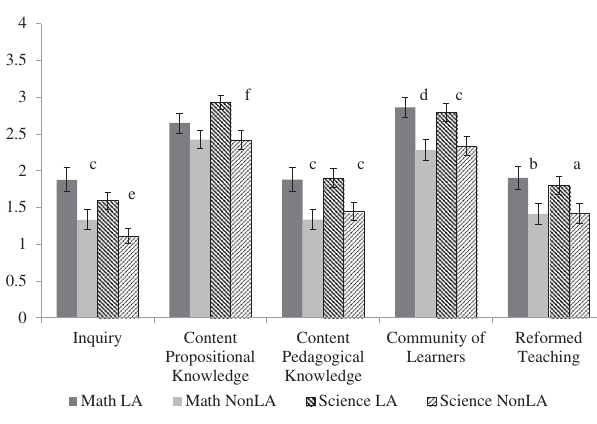
FIG. 3. Average statement response for the five factors of the RTOP. Error bars represent plus and minus 1 standard error on the mean. (a) p ¼ 0 . 03 , (b) p ¼ 0 . 02 , (c) p ¼ 0 . 01 , (d) p ¼ 0 . 003 , (e) p ¼ 0 . 002 , and (f) p ¼ 0 . 001 .